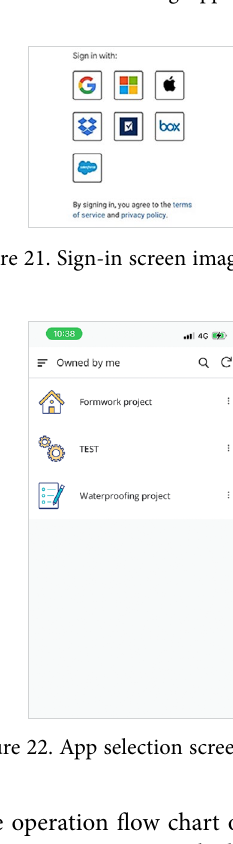
Figure 20. Downloading AppSheet app